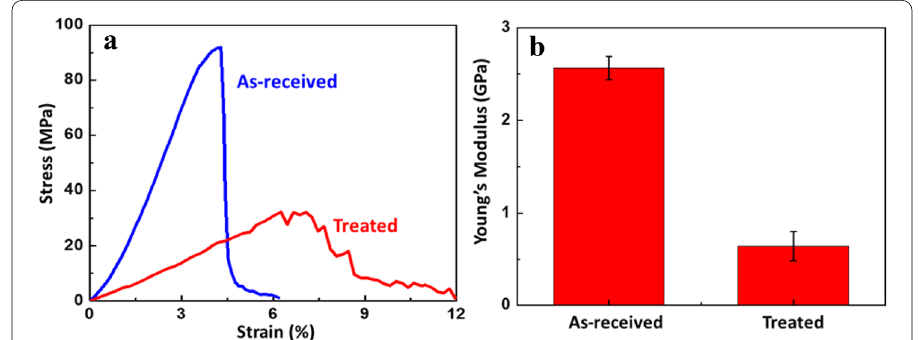
Fig. 6 Mechanical properties of as‑received and treated samples. a Stress versus strain curve. b Young’s modulus (standard deviation: as‑received